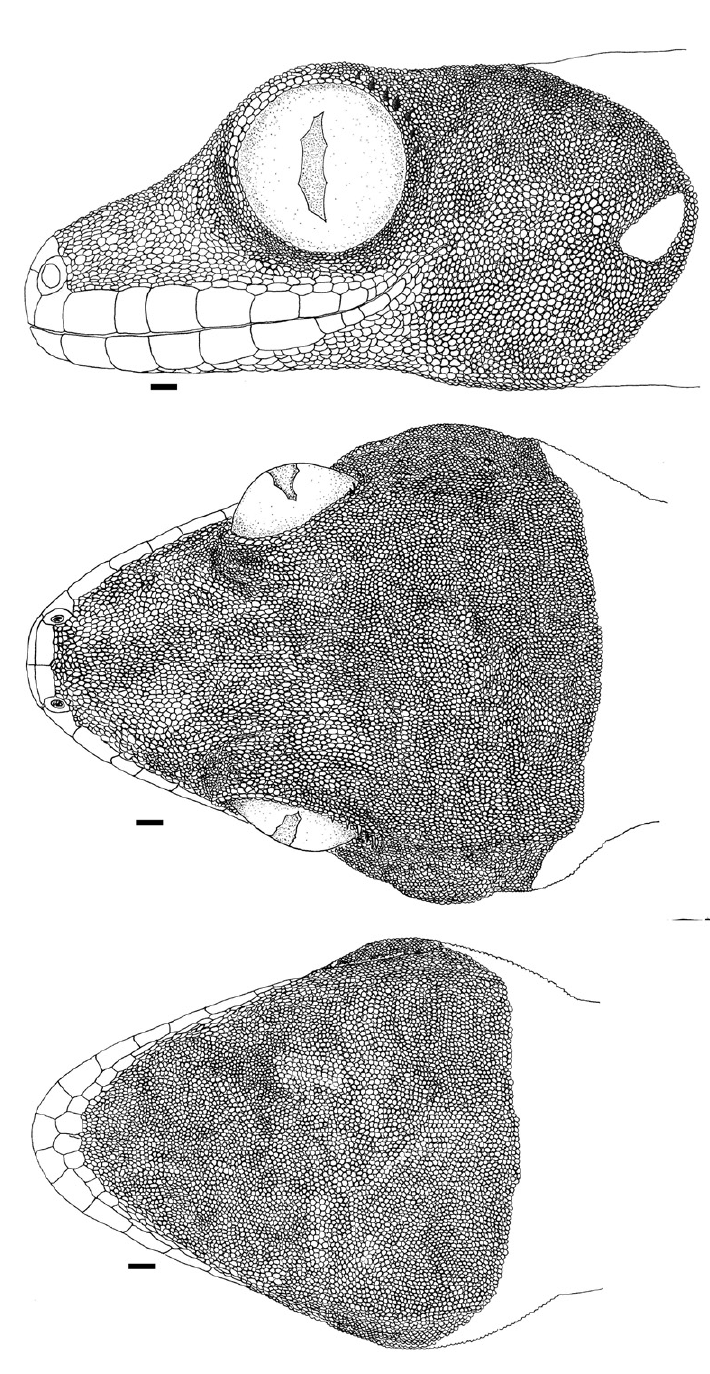
Figure 2. Head of holotype of Thecadactylus oskrobapreinorum (SMF 92120). Scale bar equals 1.0